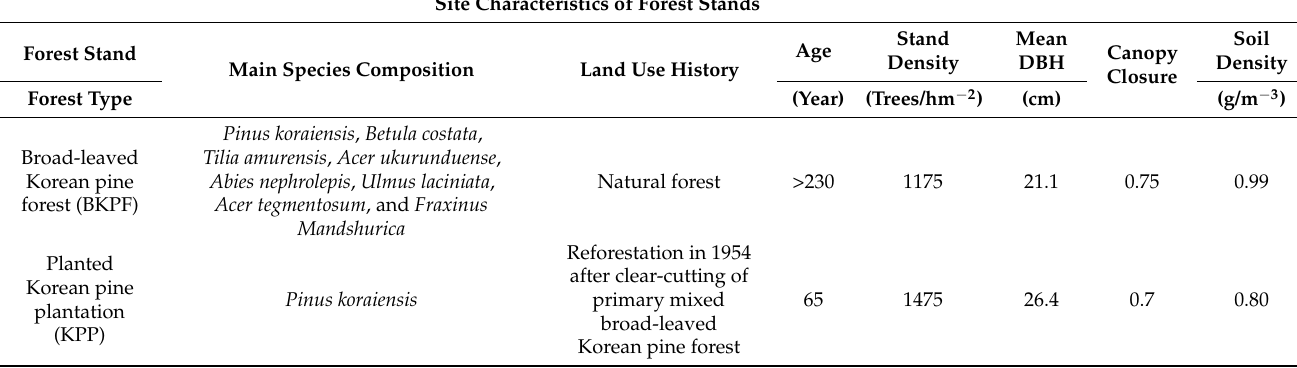
Table 1. Summary of the mixed broad-leaved Korean pine forest (BKPF) and planted Korean pine plantation (KPP).